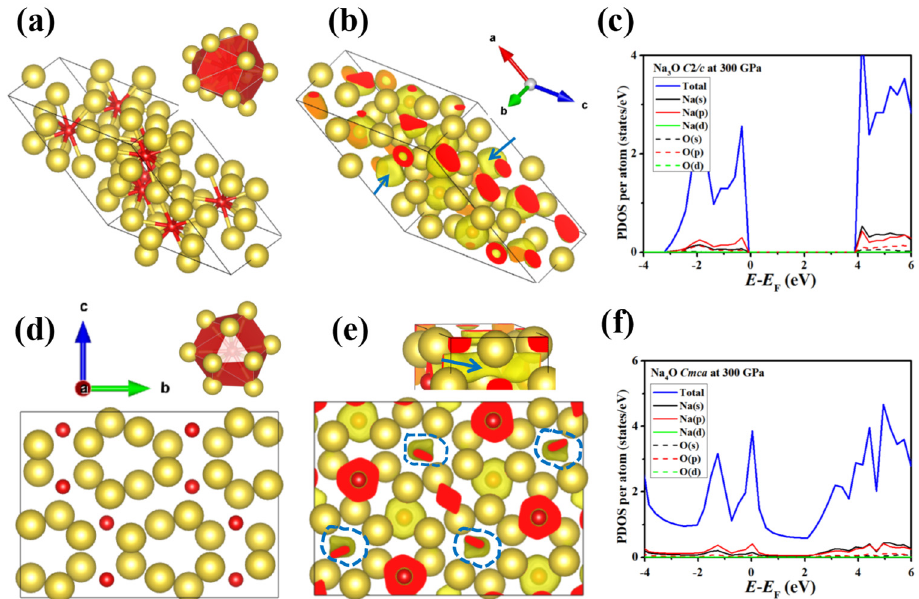
Figure 4. ( a , d ) Crystal structures, ( b , e ) ELF, and ( c , f ) PDOS of predicted Na-rich Na–O compounds at 300 GPa: ( a – c ) C 2 /c Na 3 O and ( d – f ) Cmca Na 4 O. O atoms are represented by bright red spheres; yellow spheres denote Na atoms. The interstitial electron regions are marked with blue arrows and dashed lines.